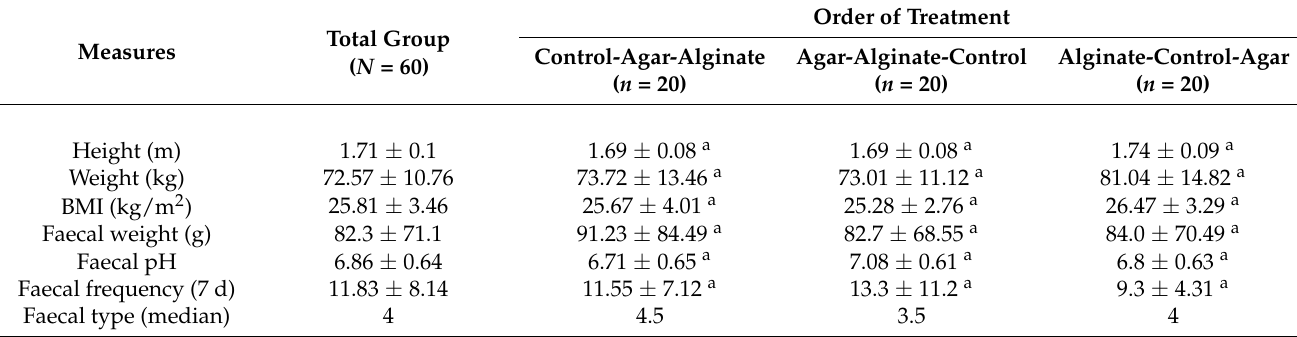
Table 1. Participant characteristics at study commencement (week 0) by allocation to order of treatment.